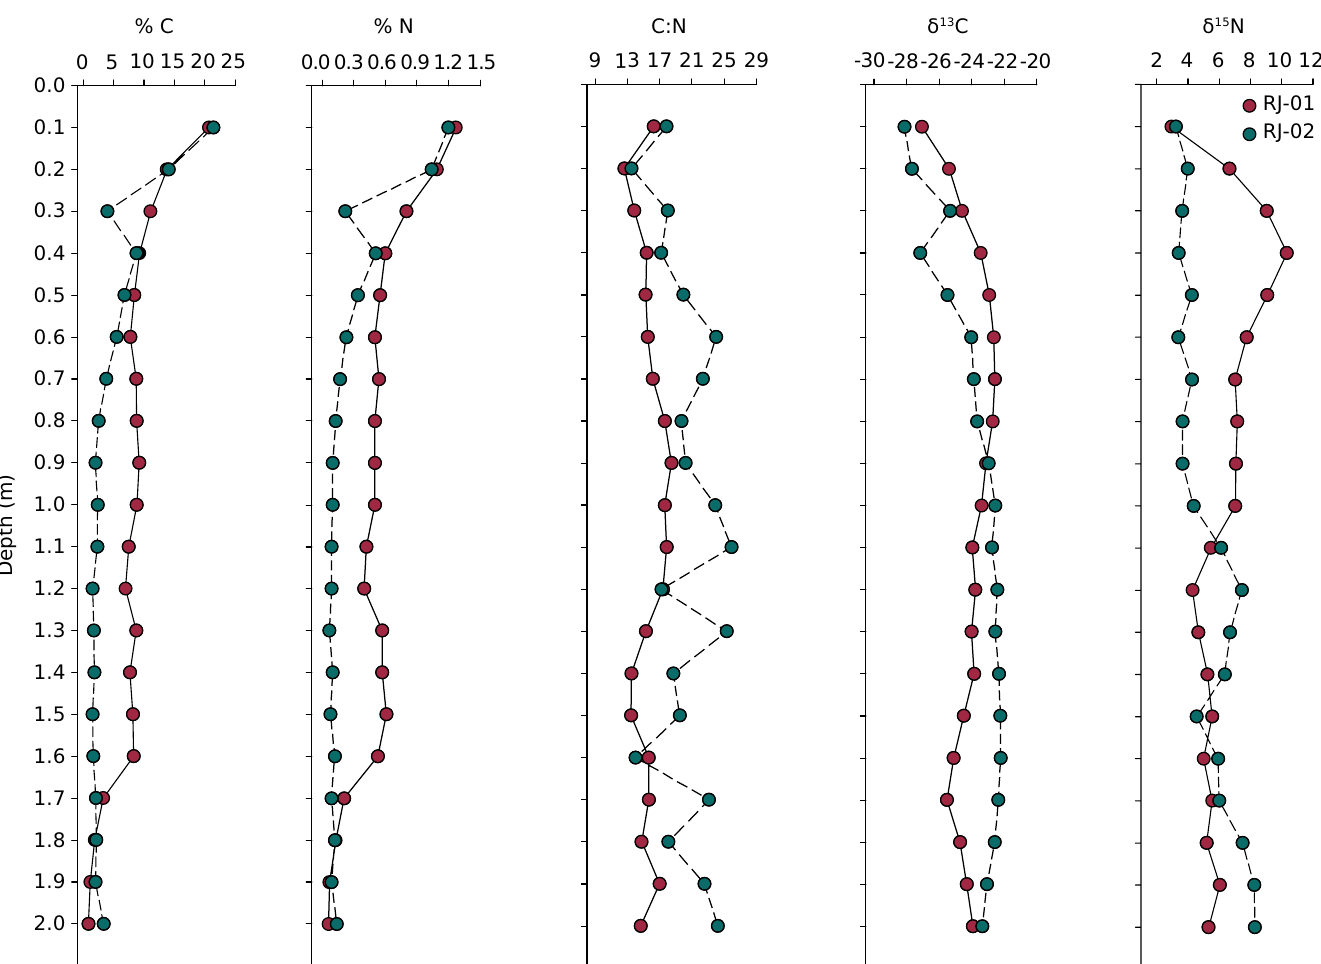
Figure 2. Distribution of carbon and nitrogen content, C:N ratio, δ 13 C and δ 15 N, for Organossolos in the upper montane environment of Itatiaia National Park, Rio de Janeiro, Brazil, with increasing